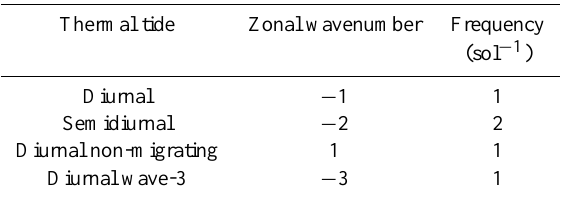
Table 2. Thermal tides retrieved by spatio-temporal short-time Fourier